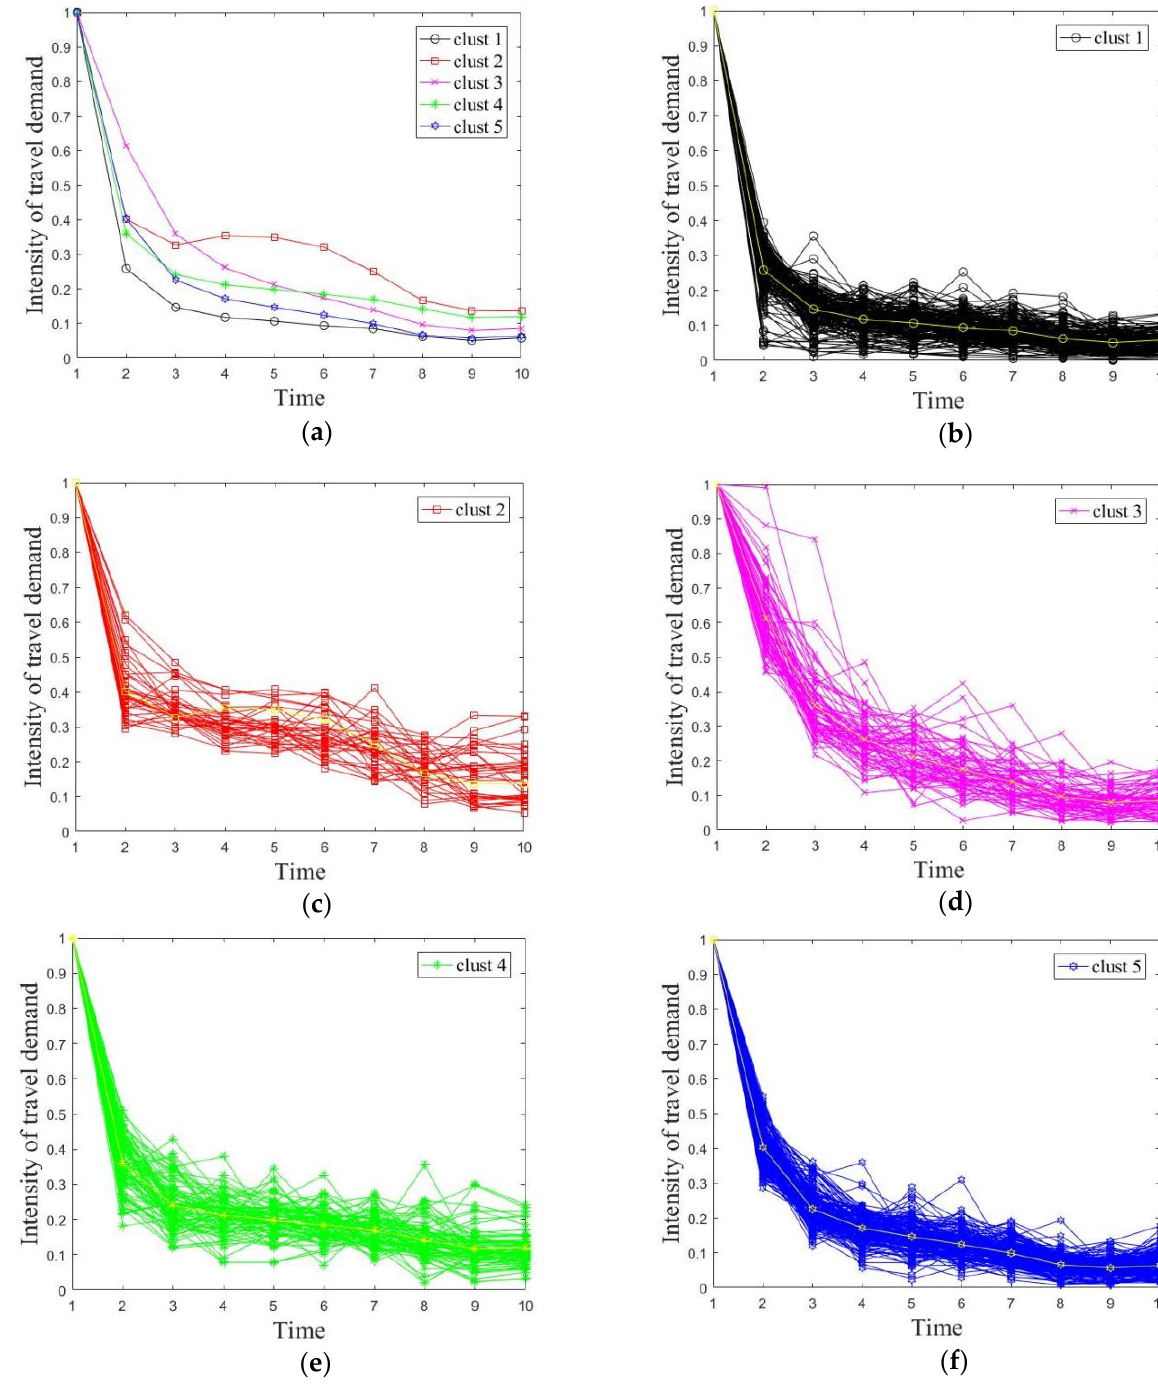
Figure 8. Time-series taxi trips of each block. ( a ) Time-series taxi trips of all blocks. ( b ) Time-series taxi trips of block #1. ( c ) Time-series taxi trips of block #2. ( d ) Time-series taxi trips of block #3. ( e ) Time-series taxi trips of block #4. ( f ) Time-series taxi trips of block #5.